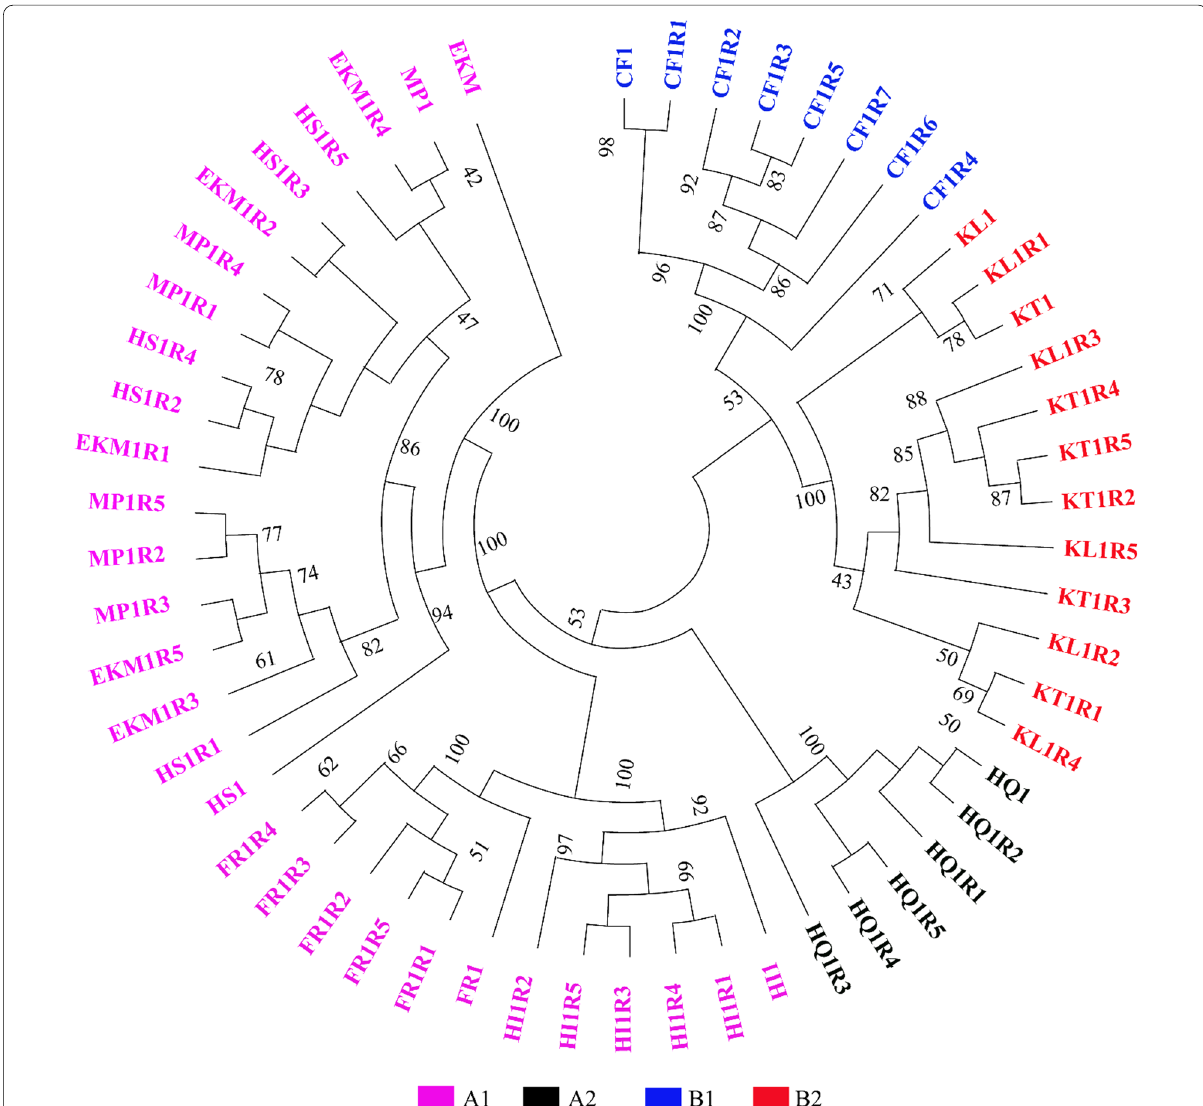
Fig. 3 Phylogenetic tree representing the relationship among EPN-associated bacteria (A and B are the major clusters of the tree, A1— Ochrobactrum spp., A2— Stenotrophomonas sp . , B1— Photorhabdus luminescens , B2— Pseudomonas aeruginosa